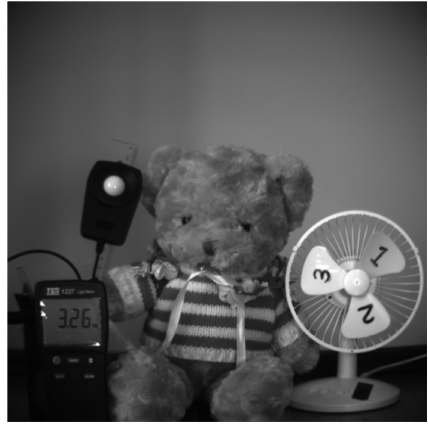
Figure 16. Snapshot of 2.5 µ m GS pixel captured with an F# 0.95 lens and exposure time of 0.24